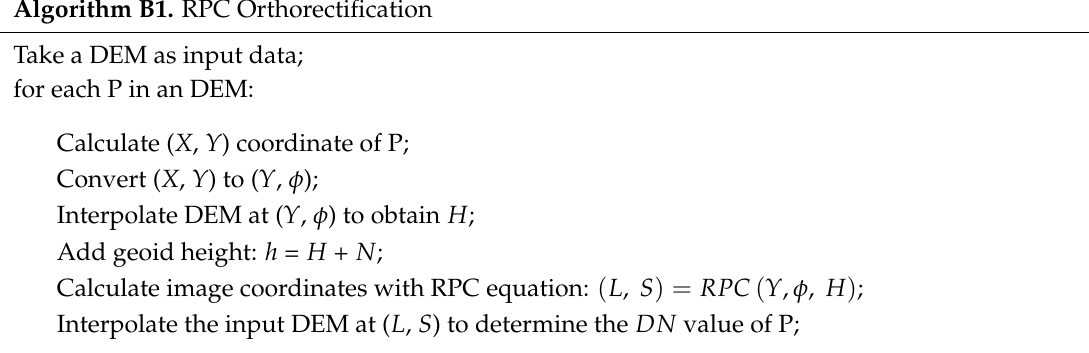
Algorithm B1. RPC Algorithm B1. RPC Orthorectification